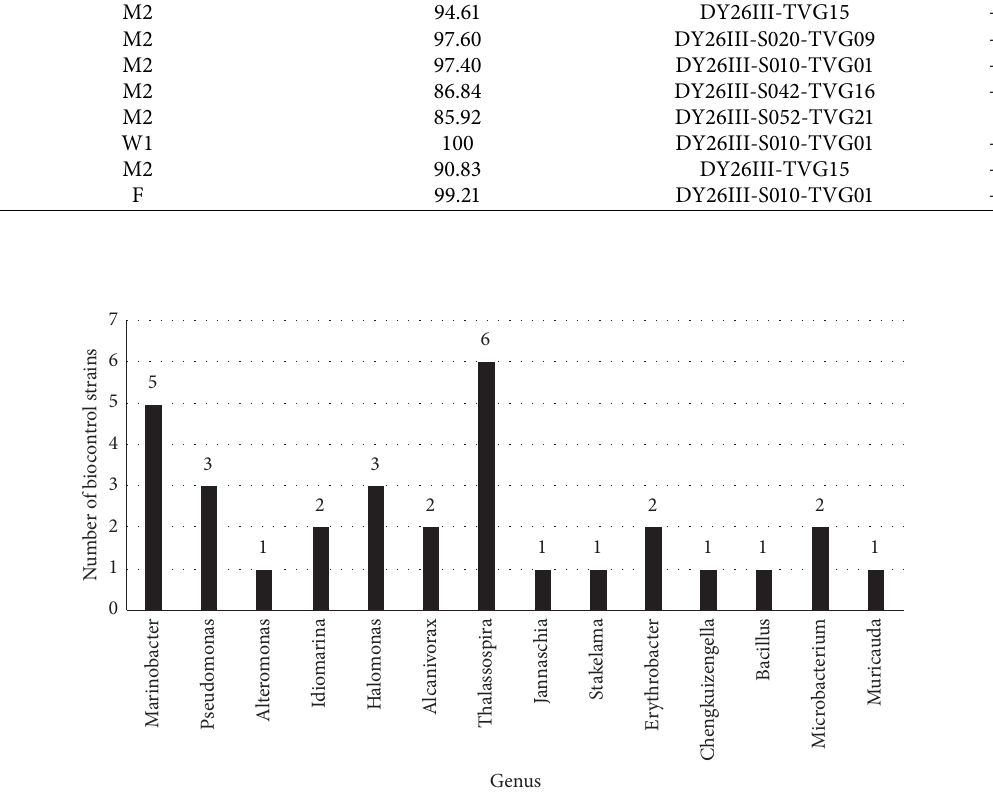
Figure 8: The strain number of different genera.